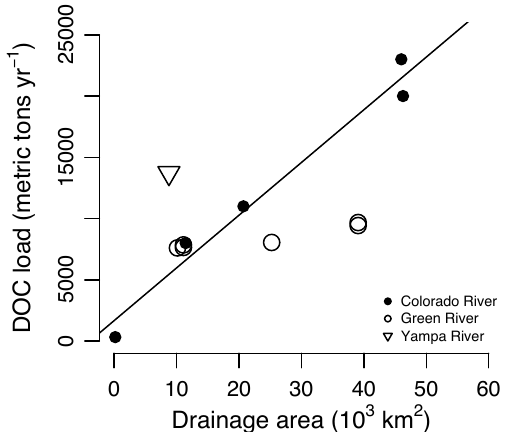
Figure 5. Annual DOC load (tyr − 1 ) plotted against drainage area (km 2 ) from the Green, Yampa, and upper reaches of the Colorado River (<50 × 10 3 km 2 ; data from Stackpoole et al., 2014, Miller, 2012). Linear regression line was fitted through data from the upper Colorado River where DOC load (tyr − 1 ) = 1675.7 + 430.1 × km 2 , P = 0.0001, r 2 =